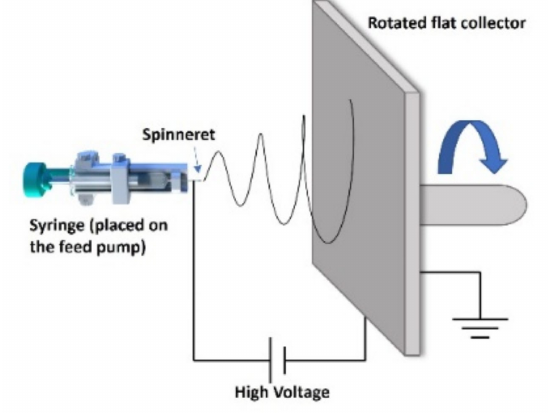
Figure 1. Schematic of the electrospinning setup utilized for the preparation of the PVDF nanofibrous